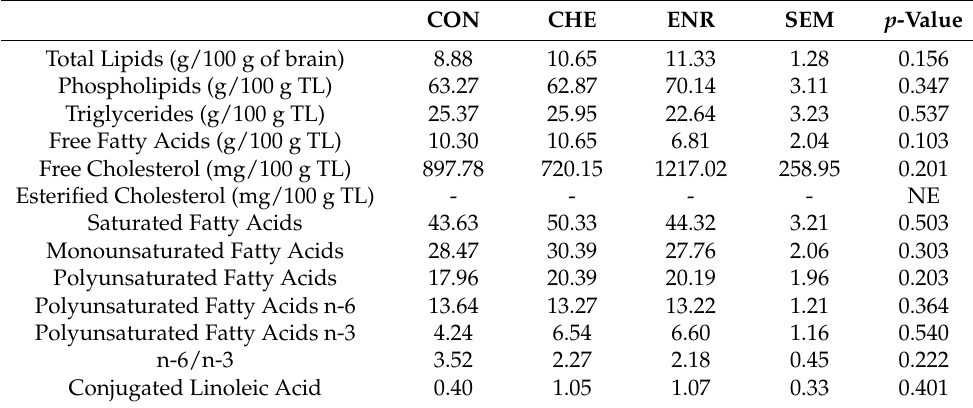
Table 4. Effect of the diet on the lipid profile of brain. CON CHE ENR SEM Total Lipids (g/100 g of